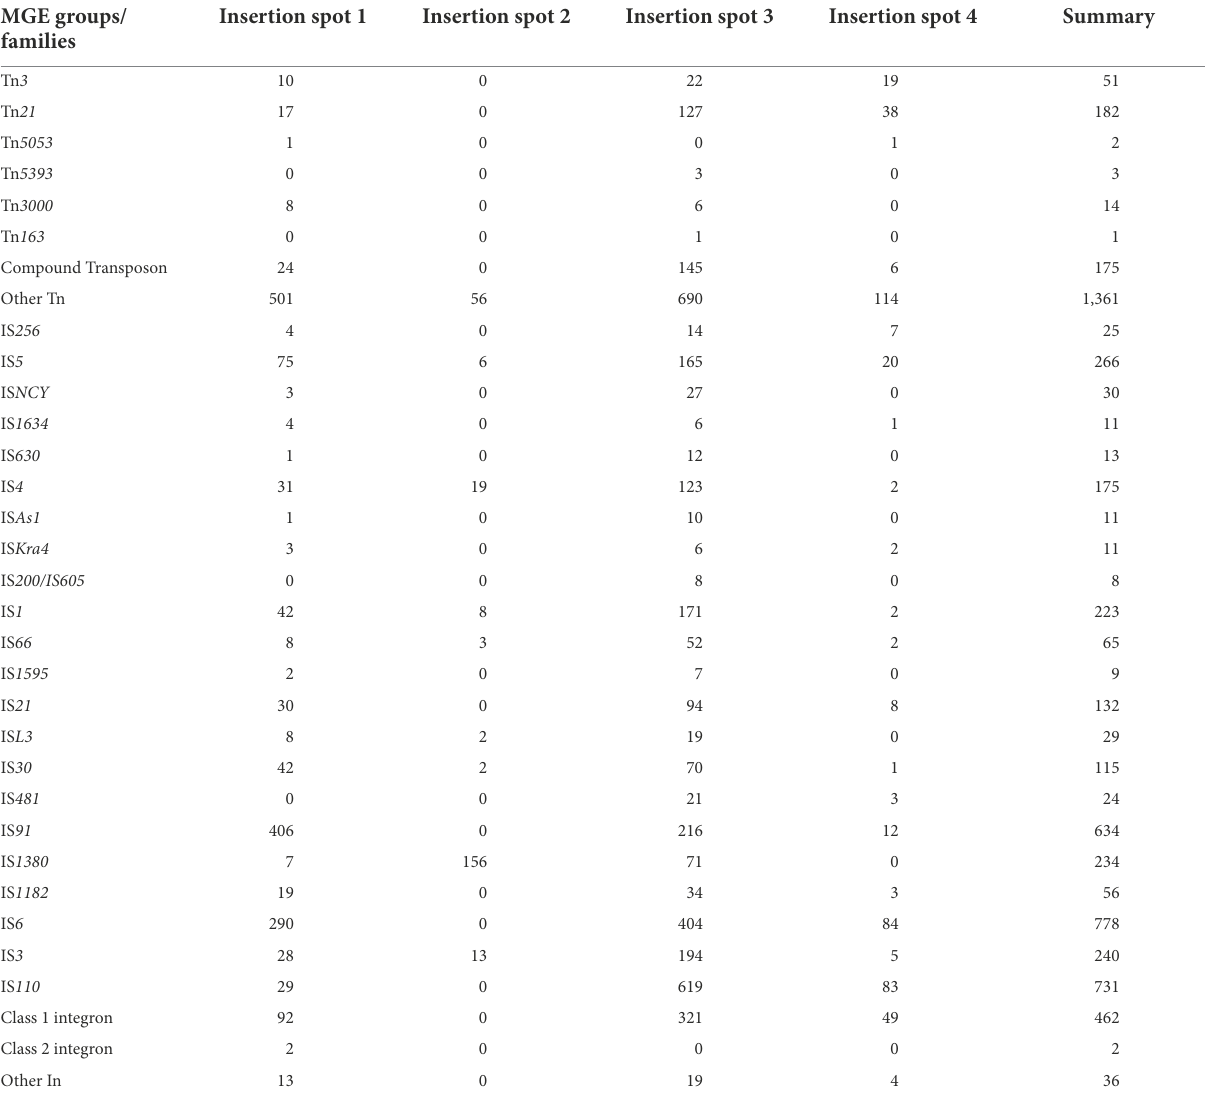
TABLE 2 Distribution of different groups/families of mobile genetic elements in the insertion insertion spots. MGE groups/